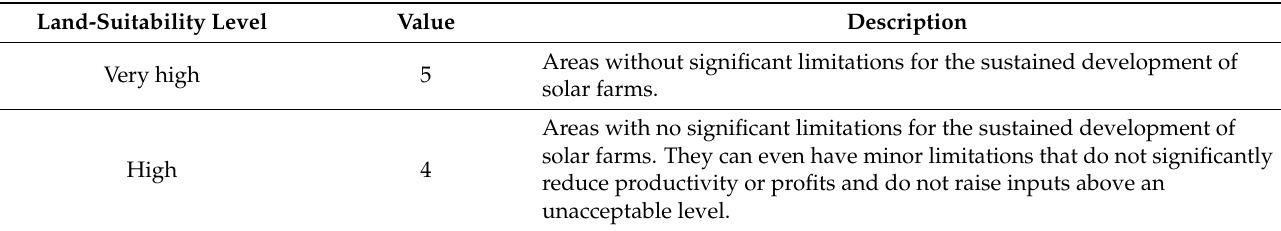
Table 6. Definition of site-suitability levels for the development of solar farms. Land-Suitability Level Value